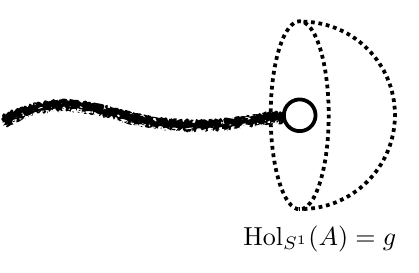
Figure 3 . A Gukov-Witten operator for a conjugacy class [ g ] in the identity component of G (represented by the fuzzy line in the picture) may end on an “improperly quantized” ’t Hooft operator, depicted here by an open dot. To have a Gukov-Witten operator end, we specify a boundary condition for the gauge field on a hemisphere of the ending locus (depicted by dotted lines) by demanding that the holonomy becomes trivial in a smooth way. By Lemma 2, this is only possible for g in the identity